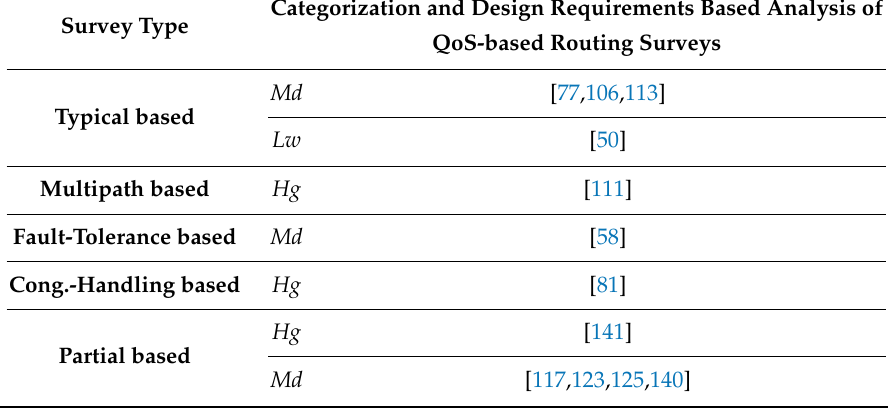
Table 10. Design analysis of QoS-based routing surveys in